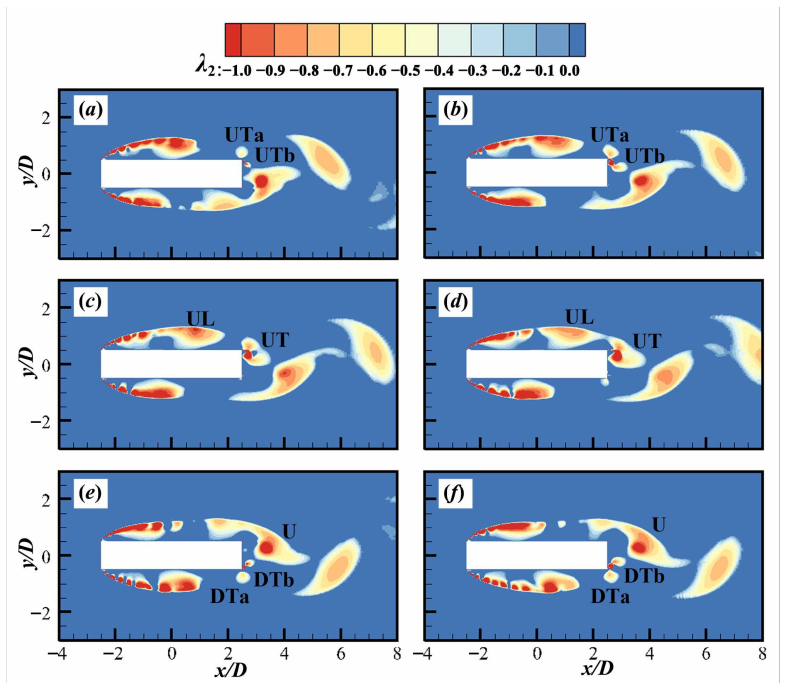
Figure 18. Vortex evolution within a vortex shedding period at α = 0 ◦ . ( a ) tU ∞ /D = 859.9, ( b ) tU ∞ /D = 861.3, ( c ) tU ∞ /D = 862.0, ( d ) tU ∞ /D = 863.4, ( e ) tU ∞ /D = 864.8, ( f ) tU ∞ /D =